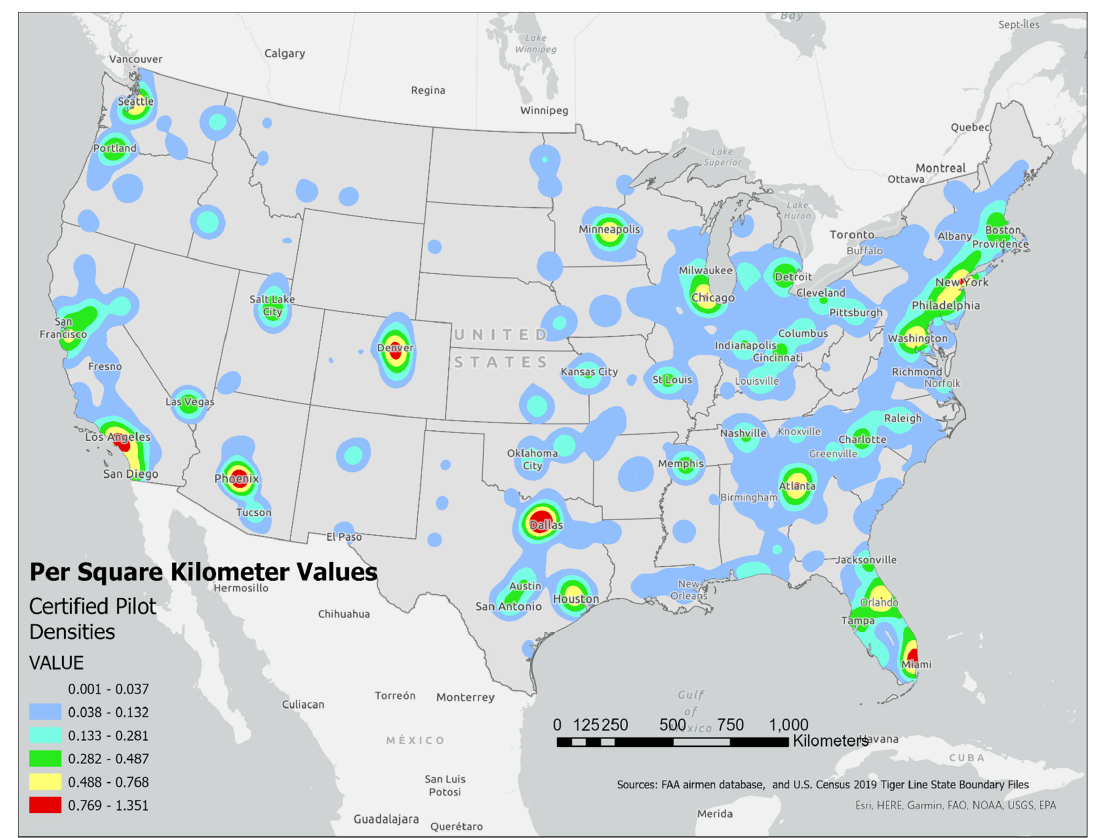
Figure 6. Kernel Density of FAA Registered Manned Pilots.